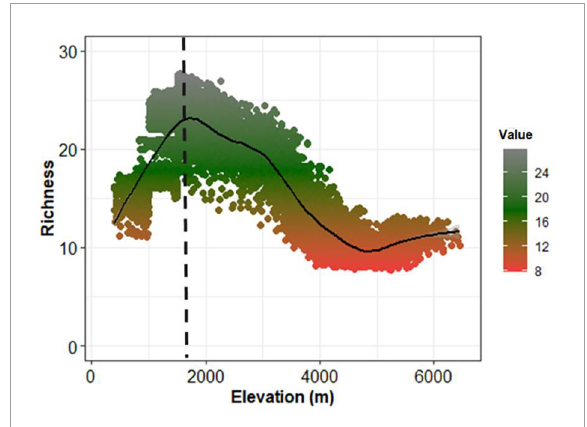
FIGURE4 Elevational pattern of predicted tree species richness showing positively skewed humped. Dotted black line indicates the richness peak. NDVI, aspect, and slope, explained 16.46, 15.18, and 11.90% of the variance, respectively, in explaining tree species